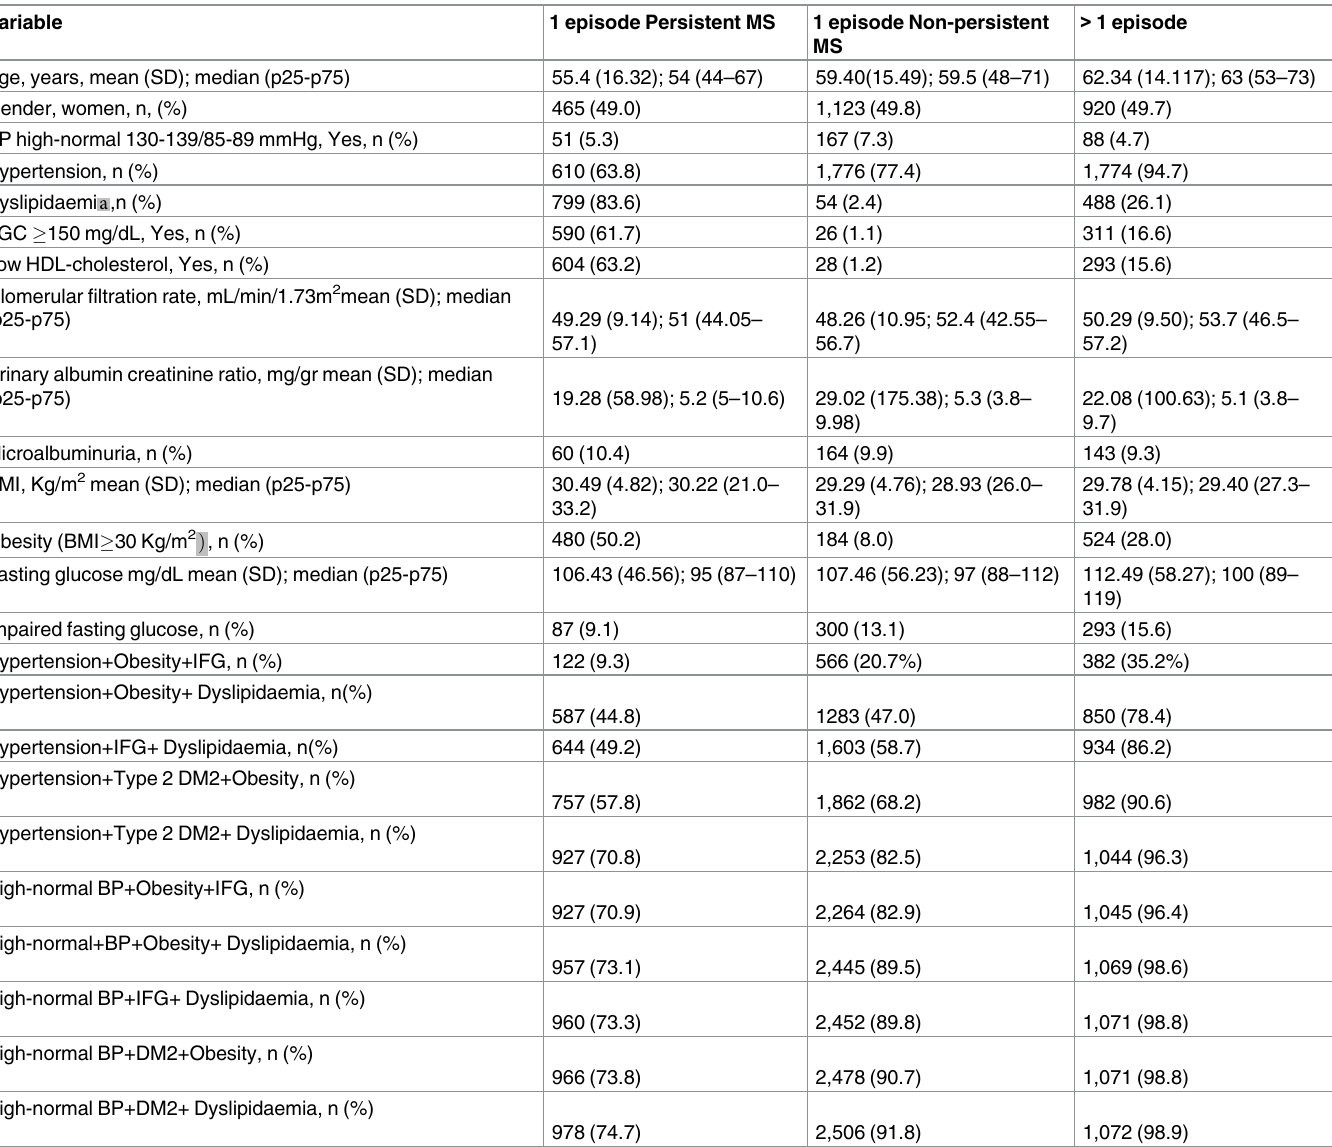
Table 3. Characteristics of participants at the moment of the first episode of metabolic syndrome, according to persistence or discontinuity. Variable 1 episode Persistent